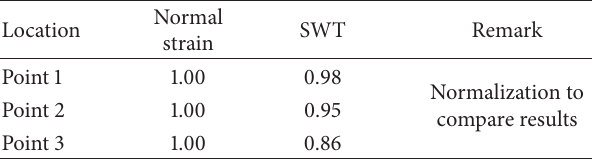
Table 7: Comparison of fatigue damage according to the fatigue evaluation